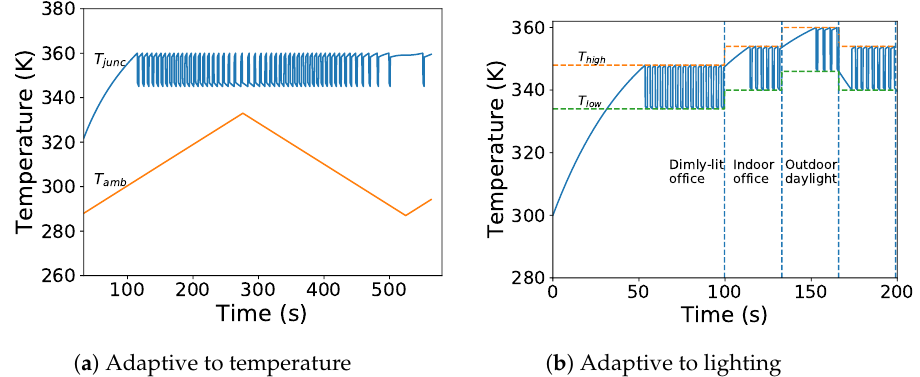
Figure 9. Increasing ambient temperature ( a ) and/or decreasing ambient illumination ( b ) pulls T NSP away from T low and pushes T CAP close to T high . Stagioni shifts thermal boundaries to smoothly steady adapt to different ambient